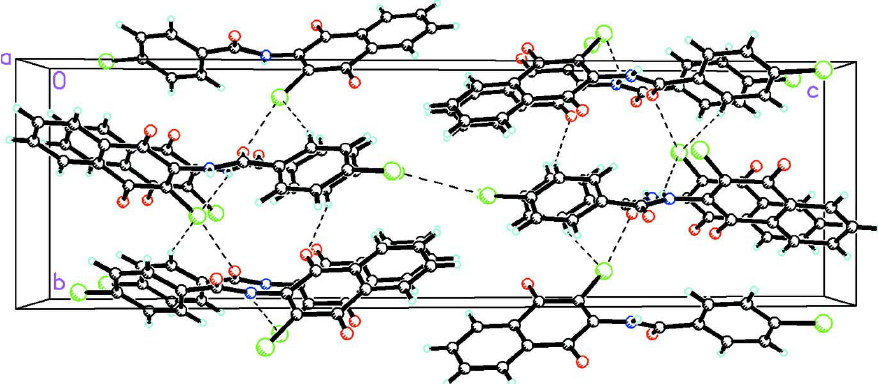
Figure 1 View of (I) showing the atom-labelling scheme. Displacement ellipsoids are drawn at the 20% probability level.